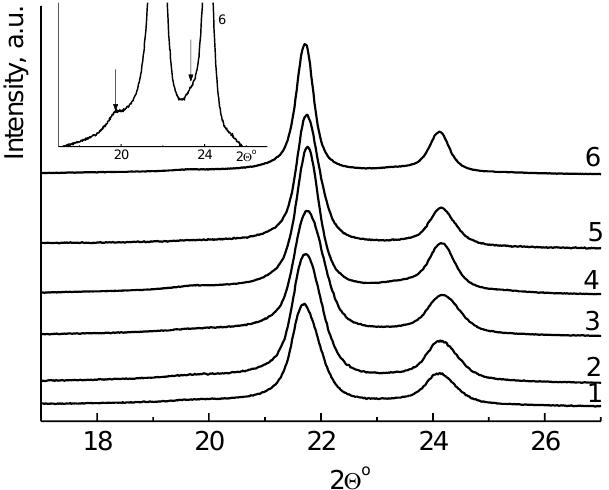
Figure 3. WAXD profiles for a series of ultrahigh molecular weight polyethylene (UHMWPE) reactor powders, obtained at 10 (1), 22 (2), 30 (3), 40 (4), 50 (5), and 70 °C (6), and a typical enlarged fragment of the WAXD profile 6 (b). The arrows indicate reflexes corresponding to the monoclinic phase (010) m and (200) m.